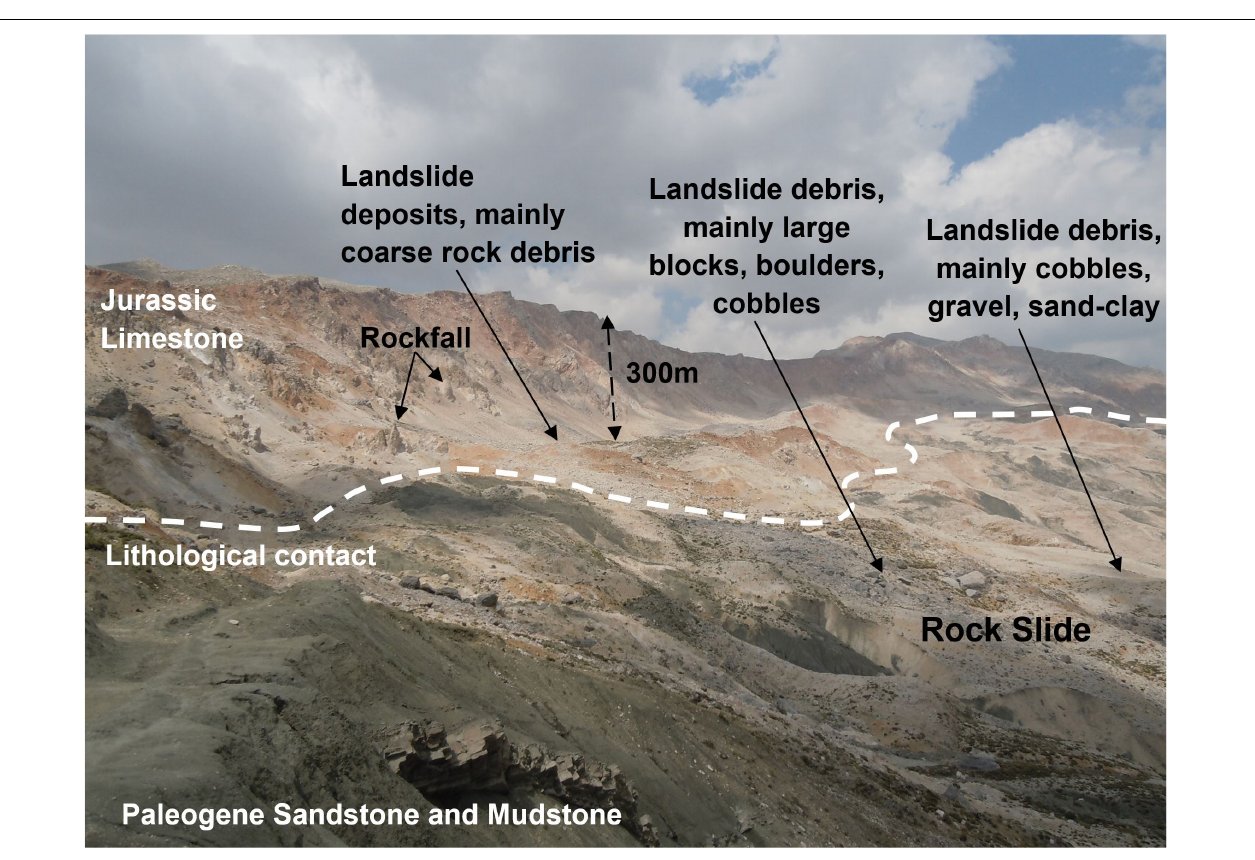
Mount Akdag was glaciated at least three times in